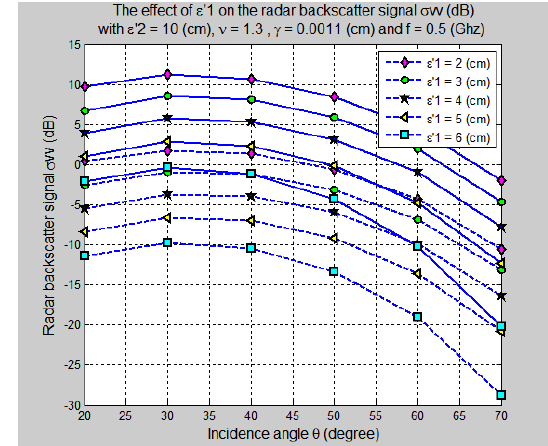
Figure 8: Backscattering coefficient dependence on 𝛆 𝟏′ at VV polarization for bare soil (dashed line) and for vegetated soil (full